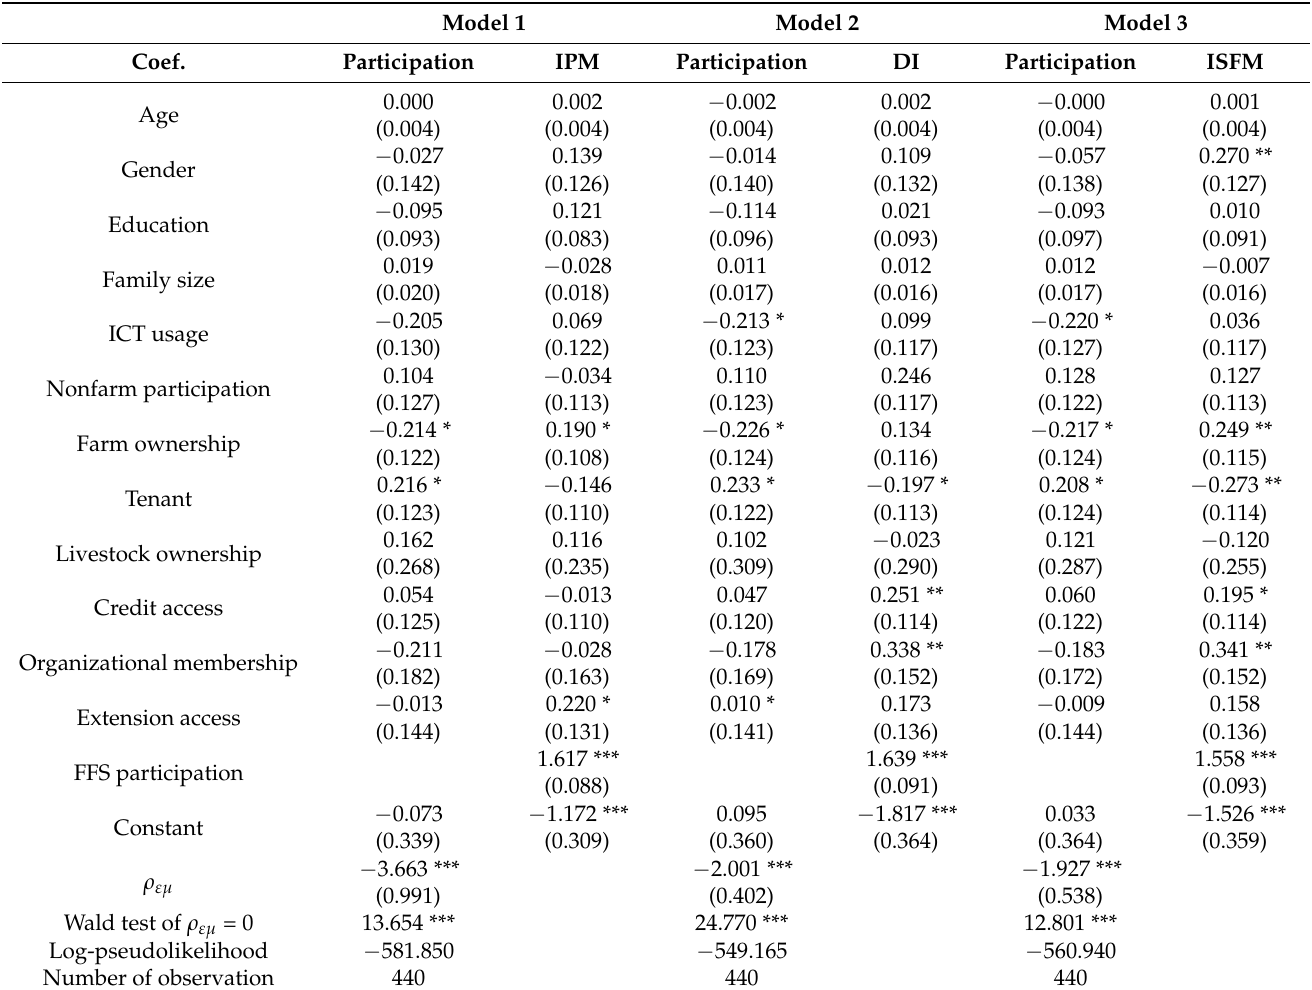
Table 4. The RBP estimates the impact of FFS participation on the adoption of